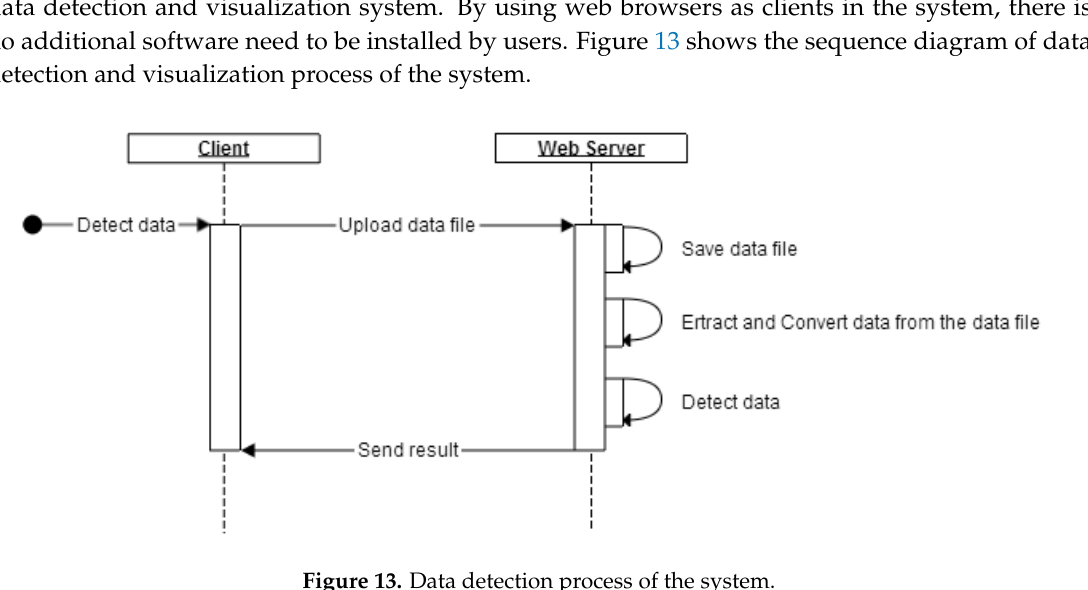
Figure 13. Data detection process of the